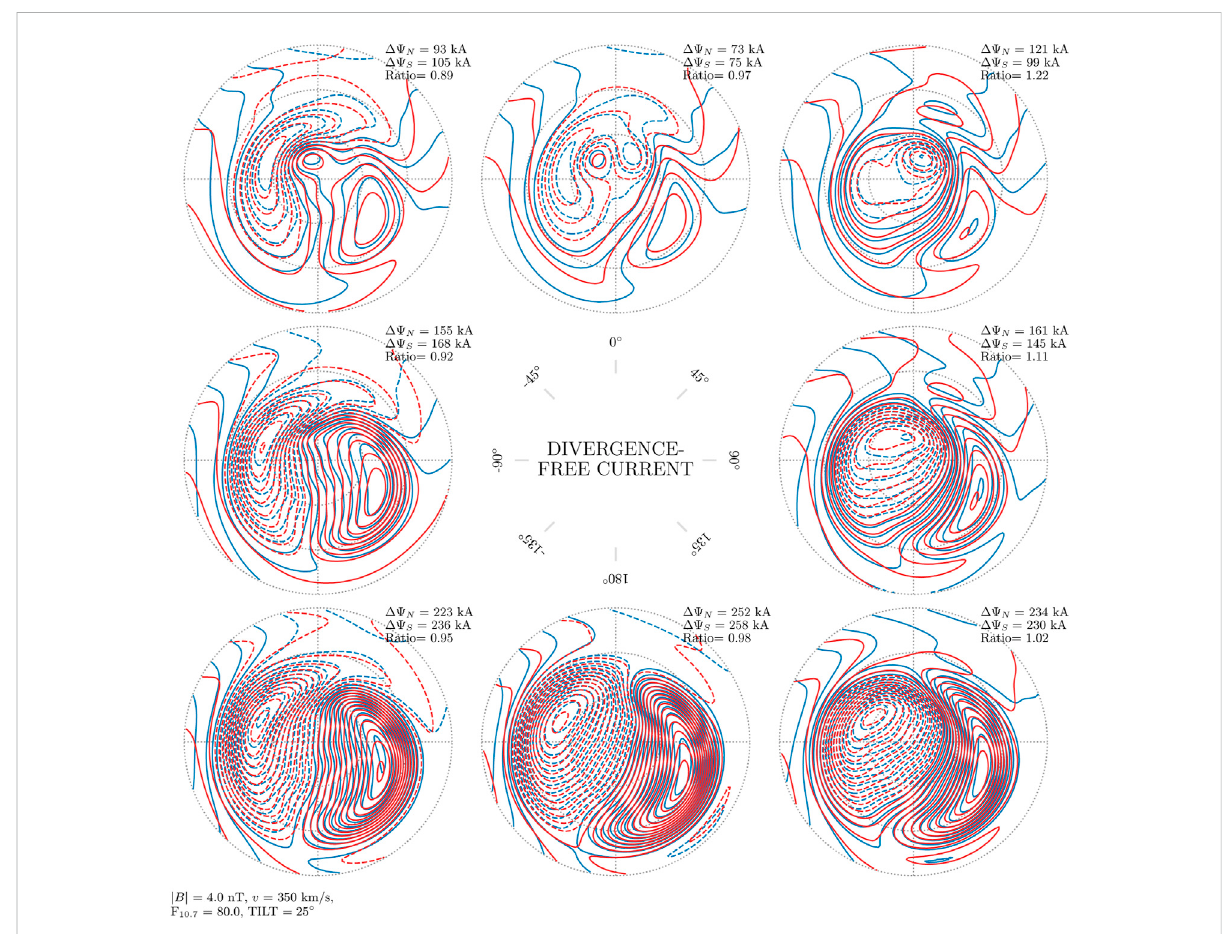
FIGURE 8 Divergence-free current function in the Northern and Southern Hemisphere as a function of IMF clock angle for dipole tilt angle ψ = 25 ° , in the sameformatas Figure 6.Inthis fi gure,themeanofthetotalcurrentsintheNorthern Hemisphere differsfrom themean totalcurrentintheSouthern Hemisphere by less than